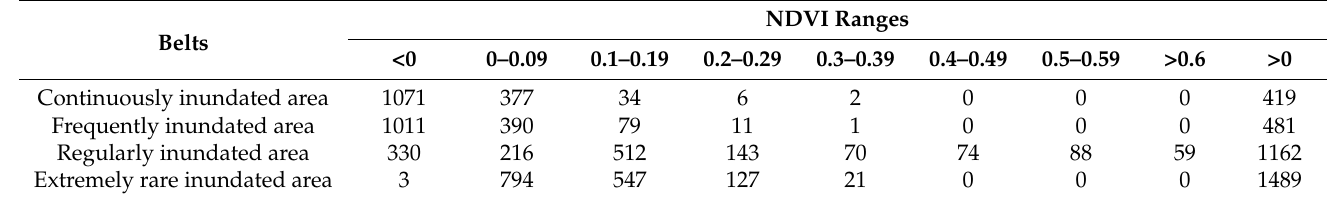
Table 2. The frequency of values in each NDVI ranges in different zones from the riverbed to the edge of three floodplains. Belts